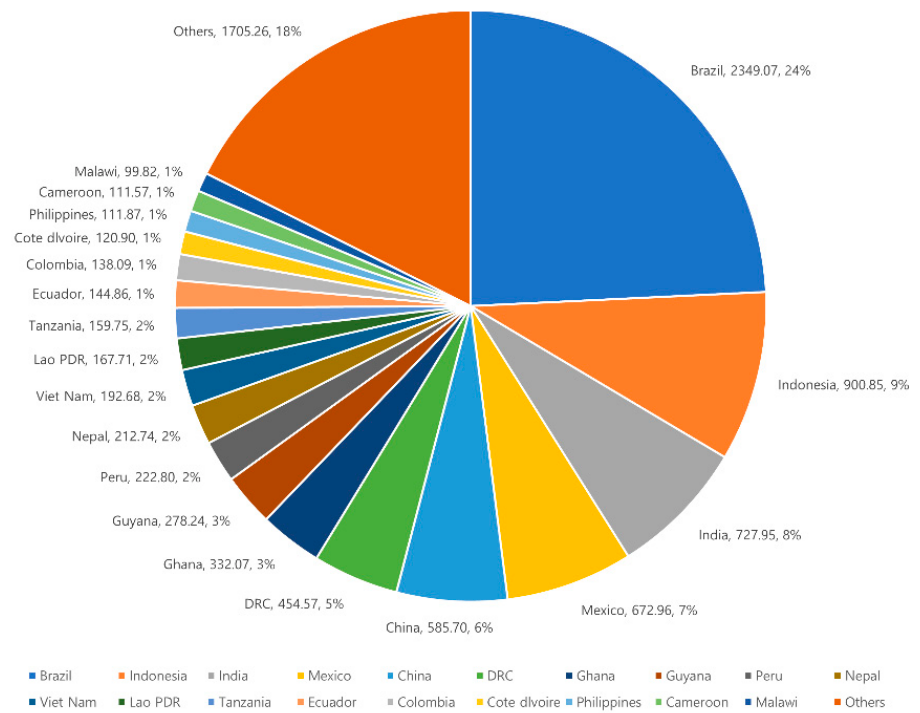
Figure 12. Amount of REDD + finance (as a percentage of a total of 9.69 billion U.S. dollars) received by recipient countries between 2006 and